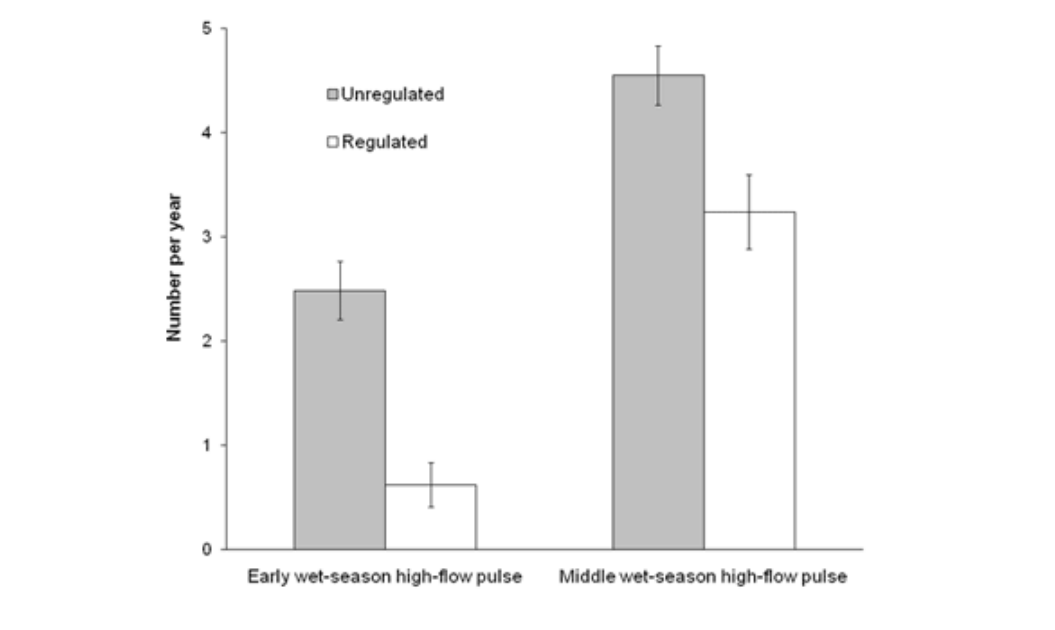
Fig. 7. Frequency of early and middle wet-season high-flow pulses with the unregulated flow regime (gray bars) and the regulated flow regime (i.e., planned dam operations without releasing environmental flow recommendations). Error bars represent the standard